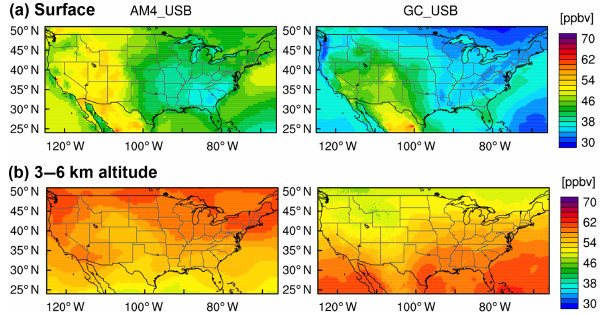
Figure 16. Spatial distributions of USB O 3 simulated with GFDL- AM4 and GEOS-Chem (a) at the surface (MDA8) and (b) at 3–6km